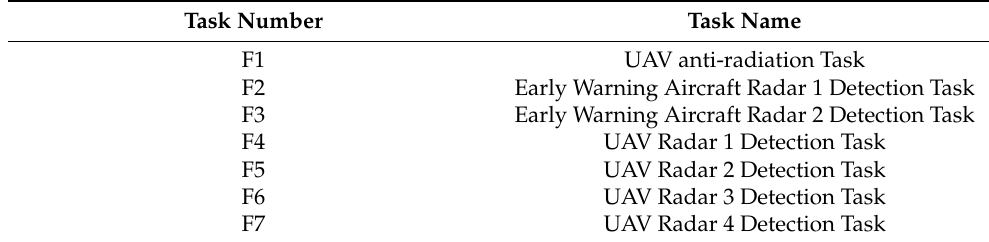
Figure 14. Task scenario model. Table 3. Task correspondence table.